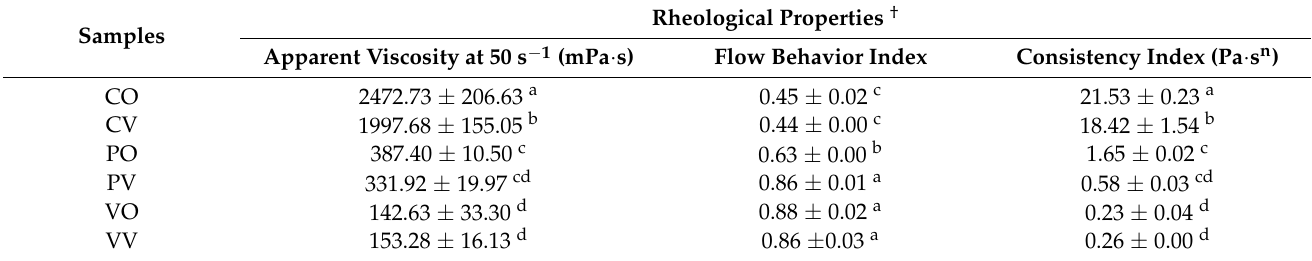
Table 2. Rheological properties of date syrups prepared using different extraction and evapora- tion